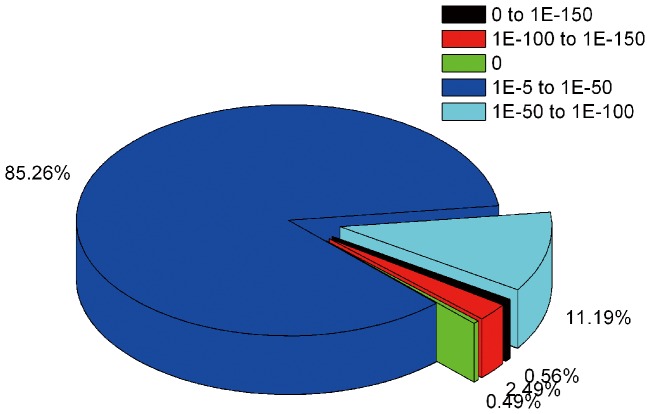
Characteristic of homology search of Illumina sequences against the nr database.E-value distribution of BLAST hits for each unique sequence with a cut-off E-value of 1.0 E−5.